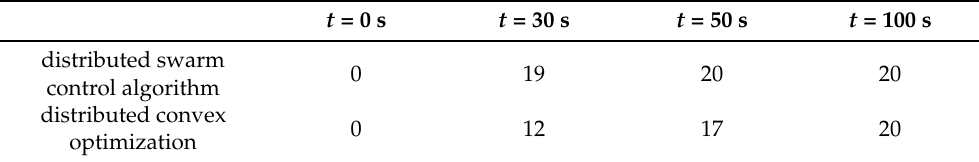
Table 2. The number of USVs achieving clusters via different algorithms ( n =